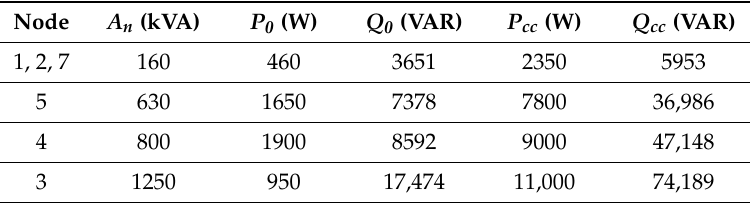
Table 5. Rated data of the MV / LV transformers powered by